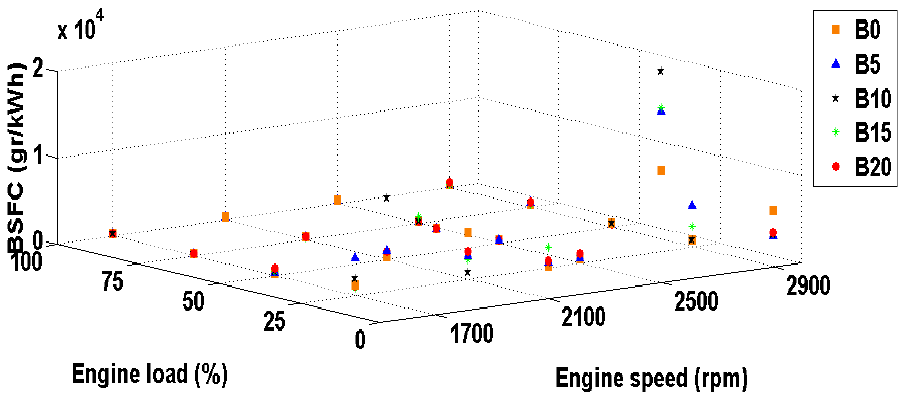
Figure 8. BSFCs of the engine under different engine loads, speeds and biodiesel percentages.